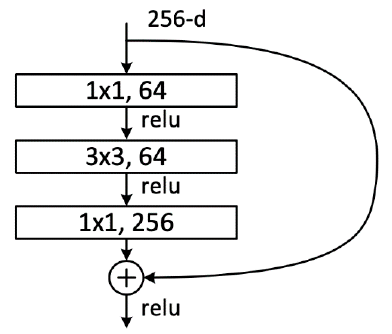
Figure 7. Schematic diagram of bottleneck [27].